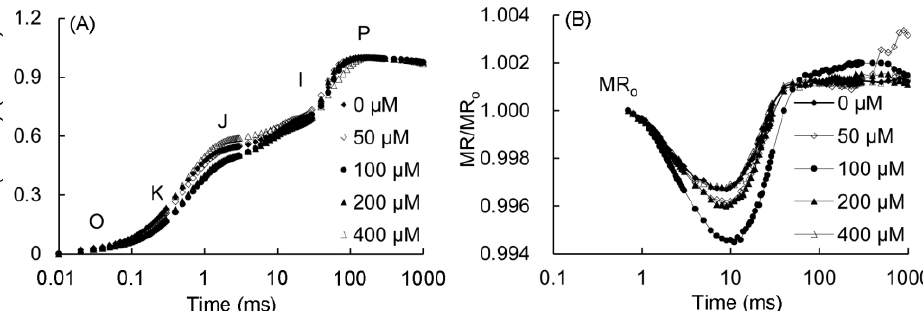
Figure 5. Fast chlorophyll fluorescence ( A ) and 820 nm modulated reflection curve ( B ) of P. vulgaris under different MT treatments. V t = (F t − F 0 )/(F m − F 0 ): the relative variable fluorescence (V t ) at any time; O, K, J, I, and P represent different phases in the OKJIP curve. MR/MR 0 : the 820-nm modulated reflection curve; MR is the modulated reflection at different time points; MR 0 is the MR value of far-red light irradiated at 0.7 ms. MT: melatonin. Data are means ± standard error; different letters indicate significant differences as determined by the Duncan test ( p ≤